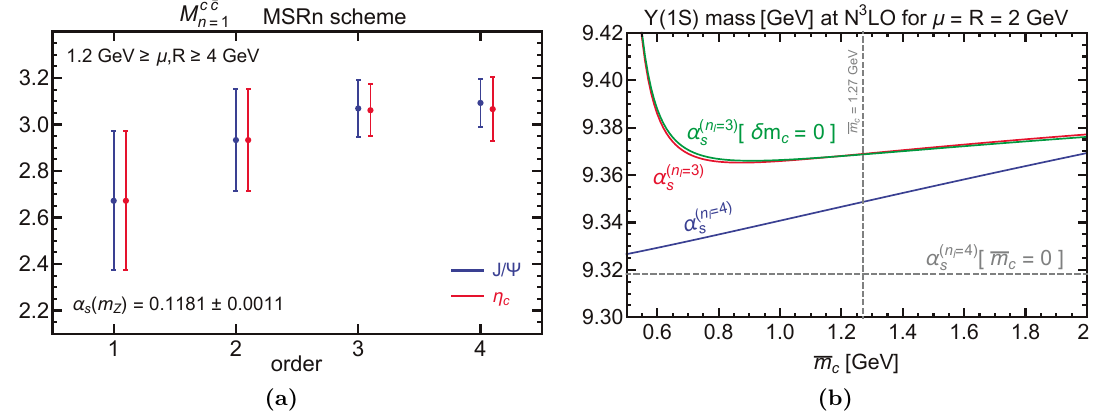
Figure 7. Left panel: mass of the n = 1 charmonium states at various perturbative orders. Blue and red colors correspond to the masses of the J= (cid:9) and (cid:17) c particles, respectively. The error bars correspond to a scale variation between 1 : 2 GeV and 4 GeV. Right panel: mass of the (cid:7)(1 3 S 1 ) bottomonium bound state in the MSRn scheme as a function of the charm mass in the MS scheme. The blue and red lines show the (cid:11) ( n ‘ =4) s and (cid:11) ( n ‘ =3) s schemes, respectively. The green line corresponds to the (cid:11) ( n ‘ =3) s scheme with no further (cid:12)nite charm mass corrections implemented. The horizontal gray dashed line shows the m c = 0 approximation in the (cid:11) ( n ‘ =4) s scheme, while the vertical dashed gray line signals the world average value for the charm quark